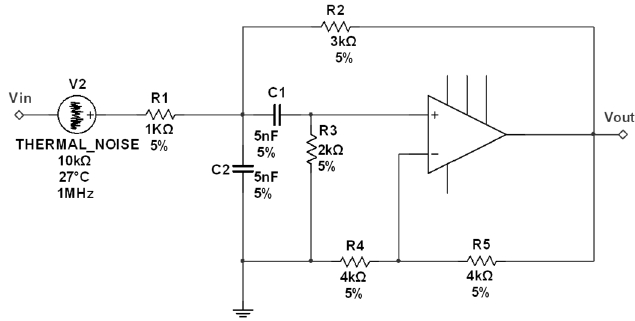
Figure 6. Sallen–Key bandpass filter circuit. Table 1. Sallen–Key bandpass filter circuit fault settings. Fault